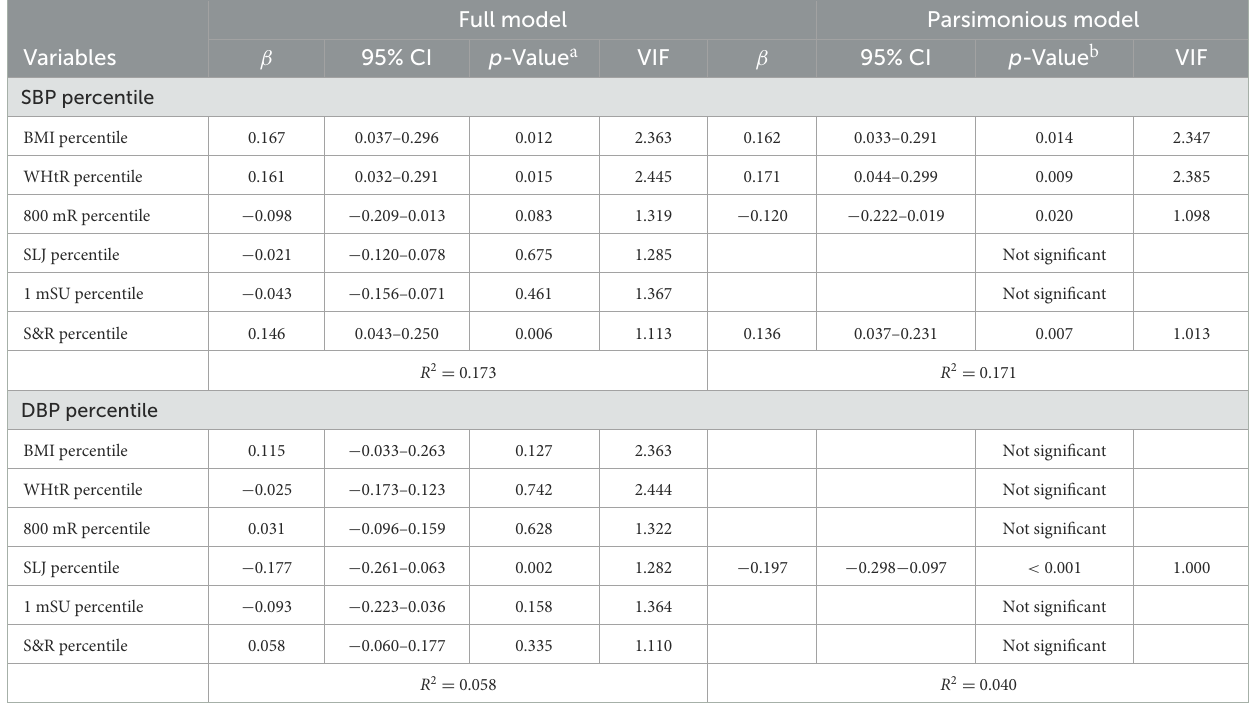
TABLE 3 Independent associations of blood pressure measures with anthropometric and physical fitness measures in the overall cohort.